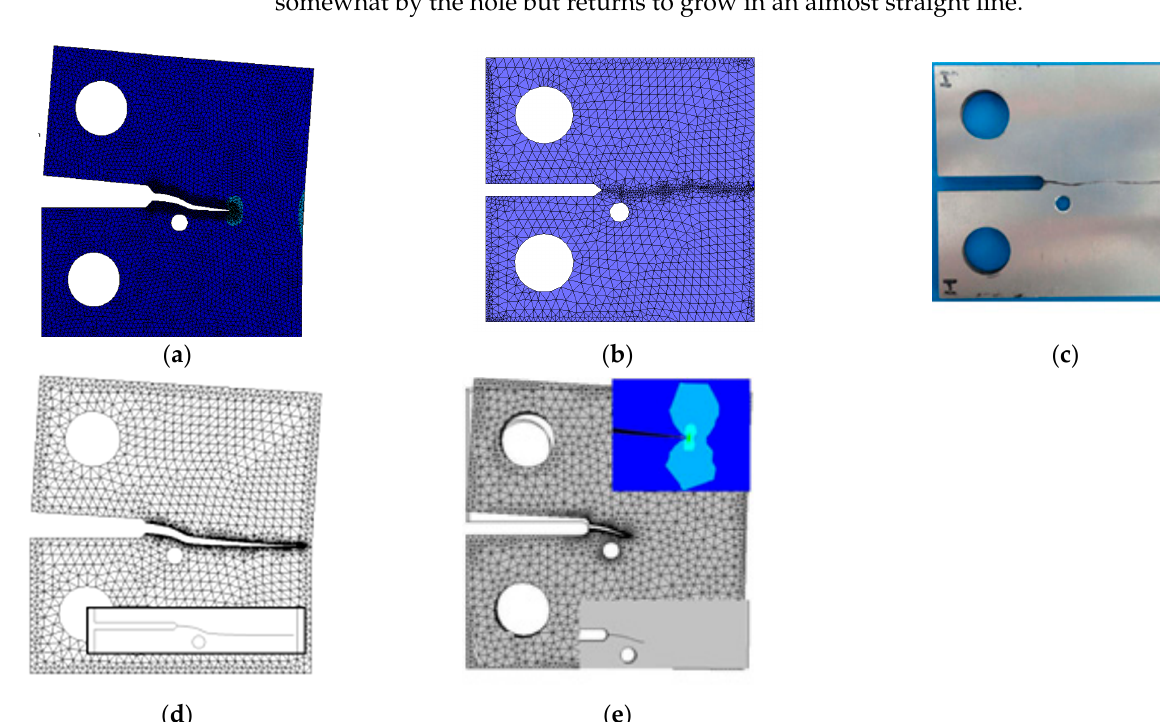
Figure 14. Predicted crack growth path for G6 specimen ( a ) ANSYS Workbench, ( b ) FRANC2D/L and ( c ) Experimental [32], ( d ) numerical [33], ( e ) FRANC3D [32].